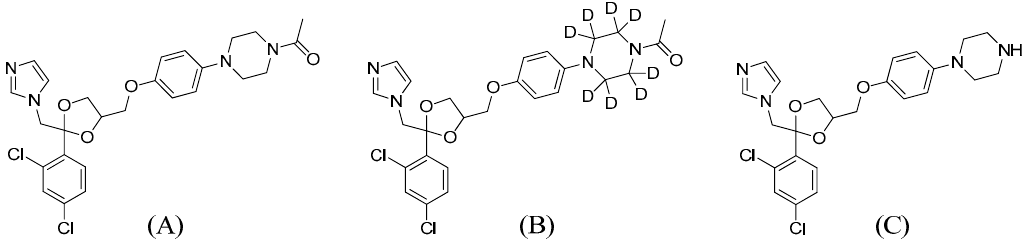
Figure 1. Chemical structures of ( A ) ketoconazole; ( B ) ketoconazole-d8; and ( C ) N